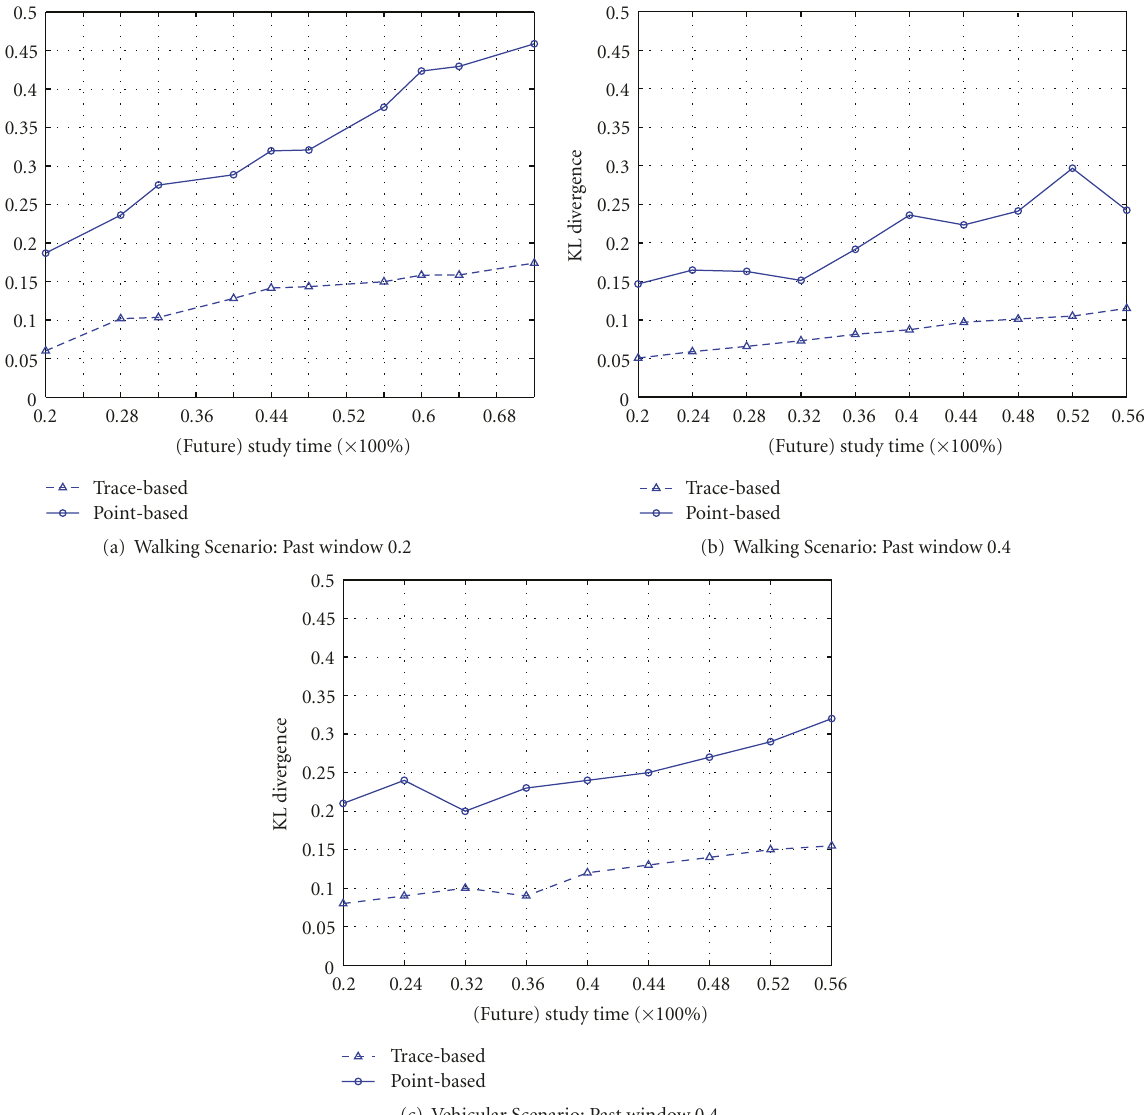
Figure 6: KL-divergence: fixed past window size; (a) and (b) the past window size is set to 0.2 and 0.4 of the total study time, respectively, when the average number of neighbors is 5; (c) the past window size is set to 0.4 of the total study time when the average number of neighbors is